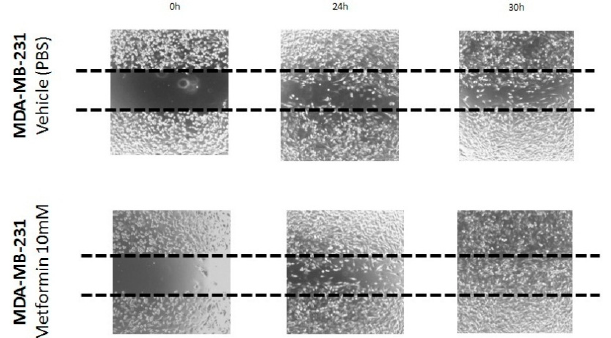
Figure 8. Wound healing cell migration assay comparing metformin-treated (10 mM) MDA-MB-231 cells with non-treated cells at 24 and 30 h. (magnification 100×)